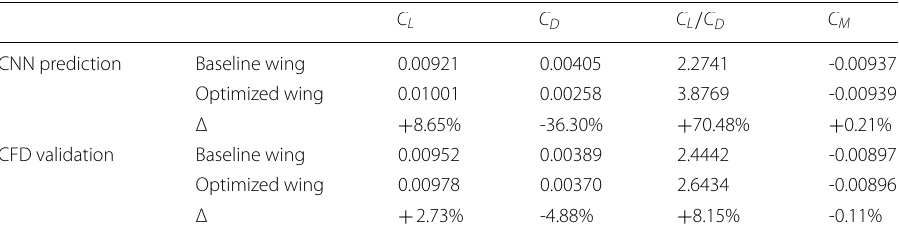
Table 12 Comparison of aerodynamic performance obtained from the CNN prediction and the CFD validation for the baseline and optimized wings (optimization case